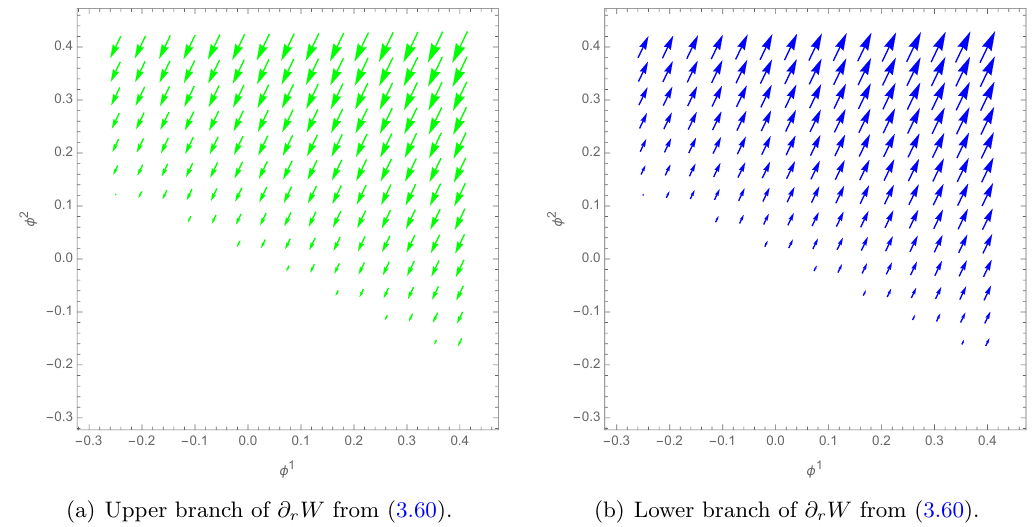
), to the vector (cid:12)elds B